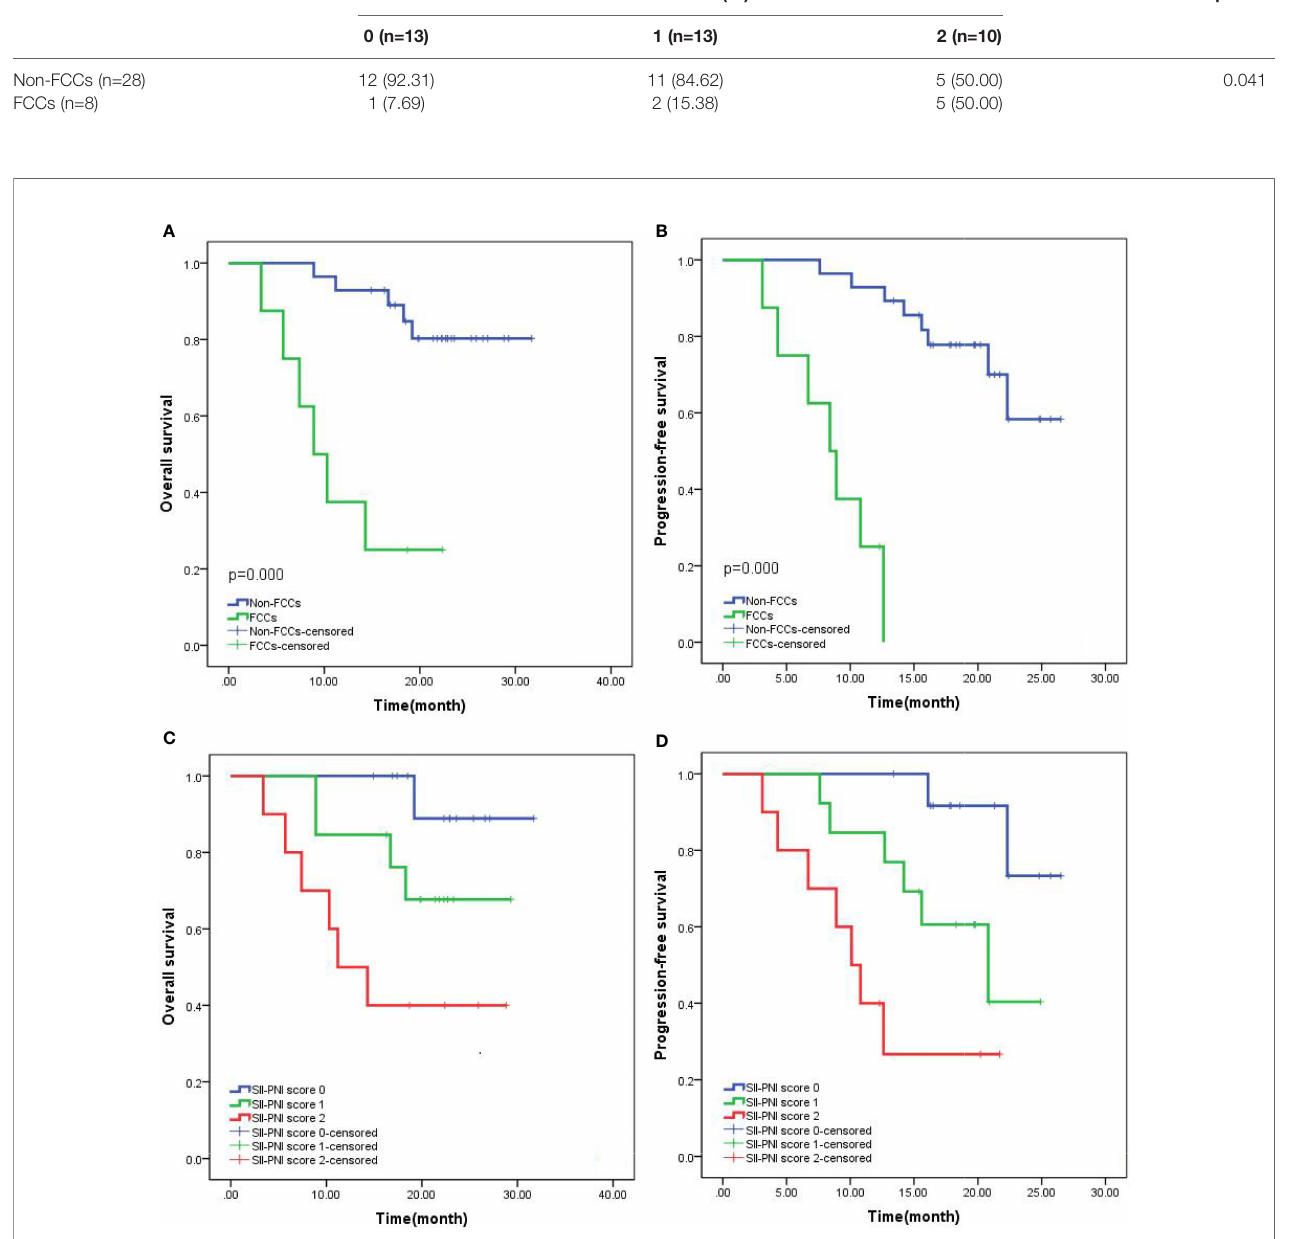
FIGURE 6 | Kaplan-Meier survival curves in patients with GC-CY 1 . (A, B) 2-year overall survival, progression-free survival based on FCCs status; (C, D) 2-year overall survival, progression-free survival based on SII-PNI